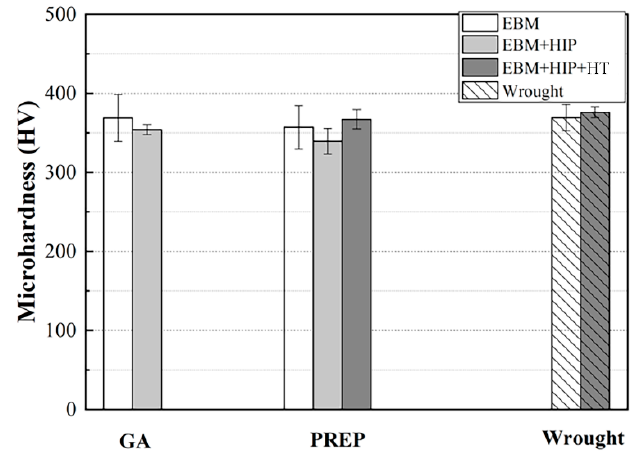
Figure 10. Measured average microhardness of GAed and PREPed GH4099 samples in EBM and EBM+HIP or EBM+HIP+HT condition compared with the wrought GH4099 in both as-wrought and wrought + HT conditions.